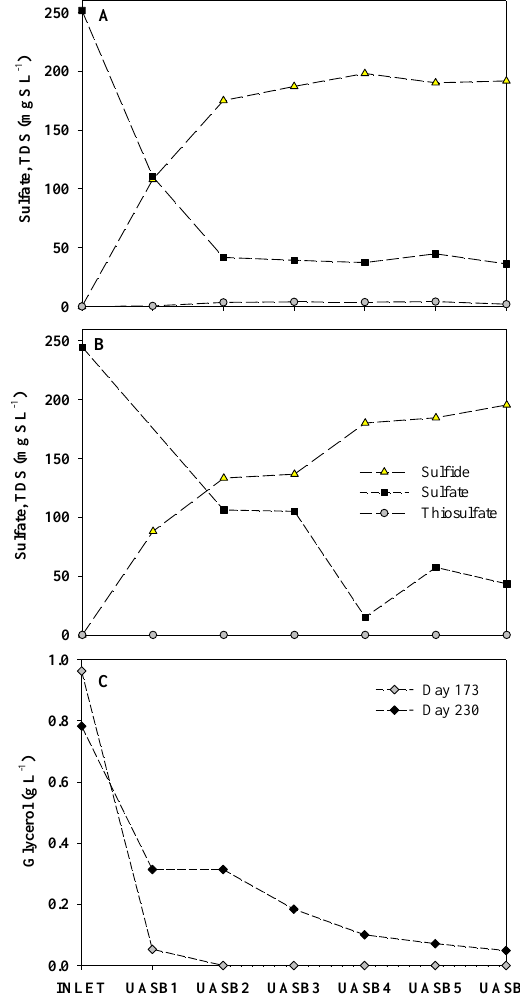
Figure 6. Experimental profiles obtained from the different reactor heights. ( A ) Sulfur species concentrations measured along the reactor´s heights on day 173. ( B ) Sulfur species concentrations measured along the reactor´s heights on day 230. ( C ) Glycerol concentration measured along the different reactor´s heights on days 173 and 230.